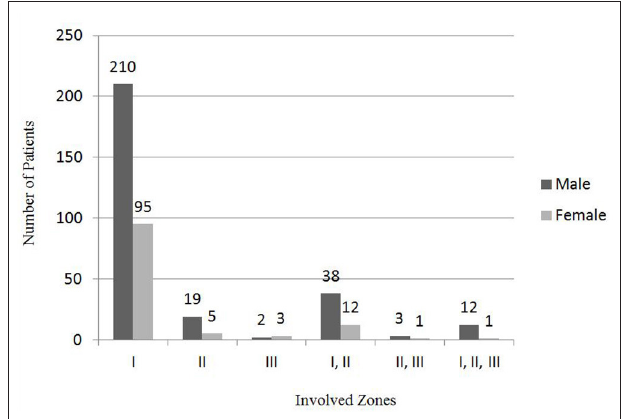
FIGURE 4 | Distribution of gender and zones involved in pediatric